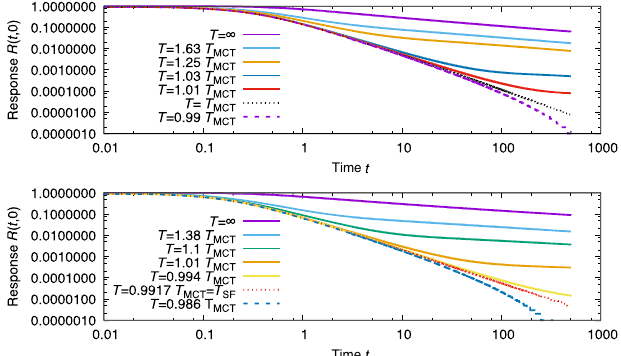
FIG. 25. The response to the initial condition R ð t; 0 Þ for various initial temperatures in the pure three-spin model (upper panel) and in the mixed 3 þ 4 -spin model (lower panel). The qualitative behavior is very similar; the higher the temperature, the higher the values of R ð t; 0 Þ . For high temperature, we see a slow decay of R ð t; 0 Þ , possibly a power law. At low temperature, below T in MCT the pure model and below T in the mixed model, the decay is SF